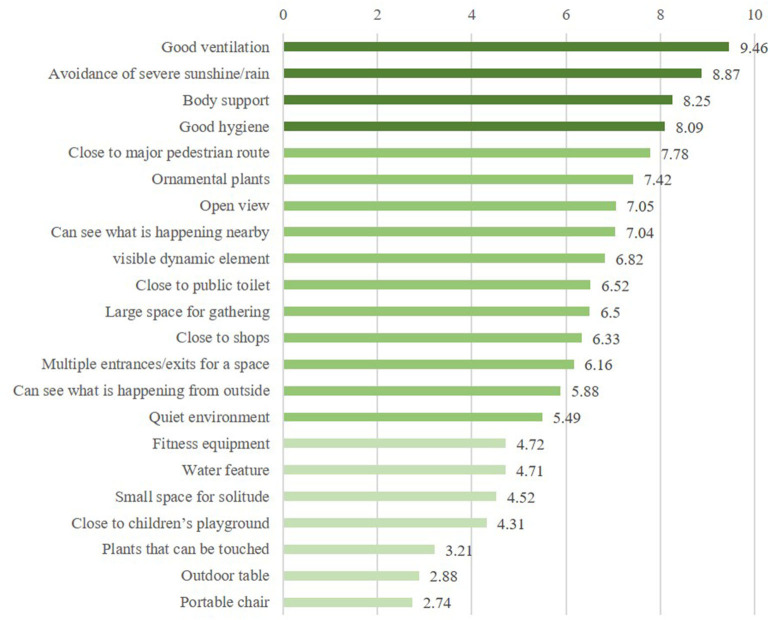
Perceived importance of each landscape element/feature (ranked).